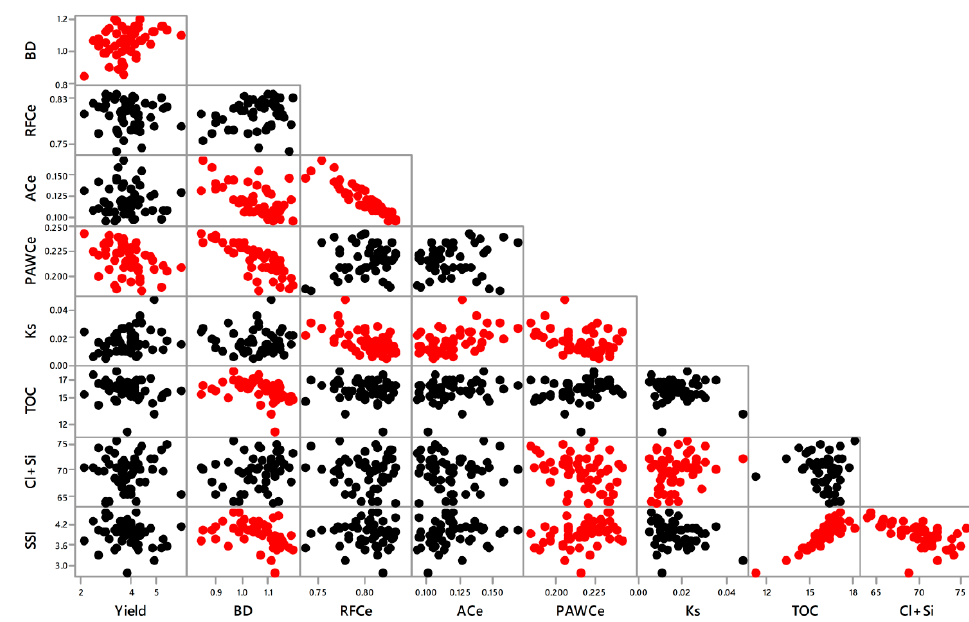
Figure 4. Bivariate scatterplots for the variables under study. Red dots highlight significant correlations at P < 0.05. BD is the bulk density (g cm − 3 ), Cl + Si is the sum of clay and silt content (%), Ks is the saturated soil hydraulic conductivity (mm s − 1 ), TOC is the soil total organic carbon (g kg − 1 ), SSI is the structure stability index (%), PAWCe is the plant available water capacity (cm 3 cm − 3 ), ACe is the air capacity (cm 3 cm − 3 ) and RFCe is the relative field capacity (dimensionless).